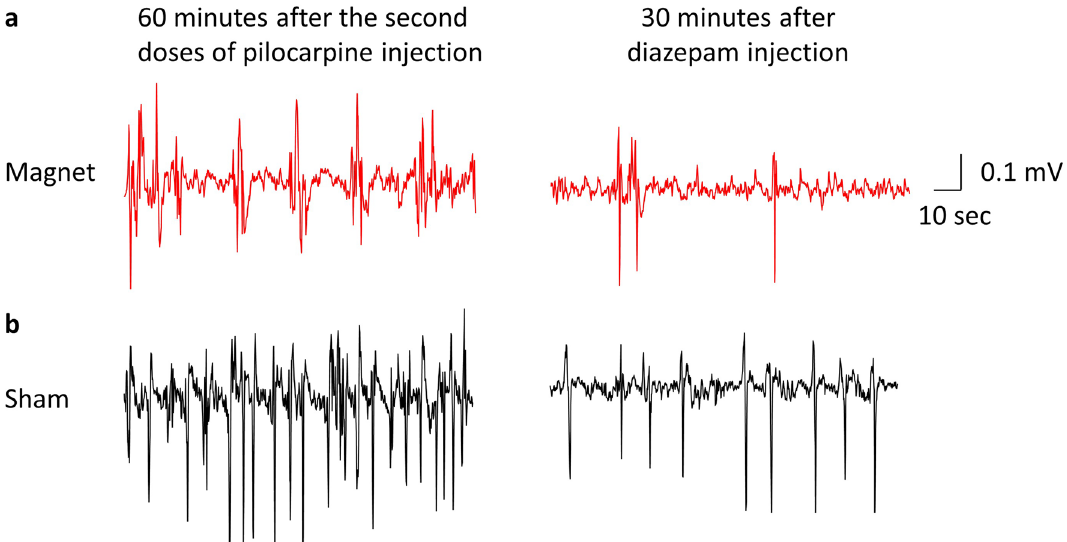
Figure 2. A 10 s sample EEG of two animals obtained 60 min after the second dose of pilocarpine (left) and 30 min after diazepam injection (right). Red traces represent the animal exposed to the real magnet ( a ). Black traces represent the sham ( b